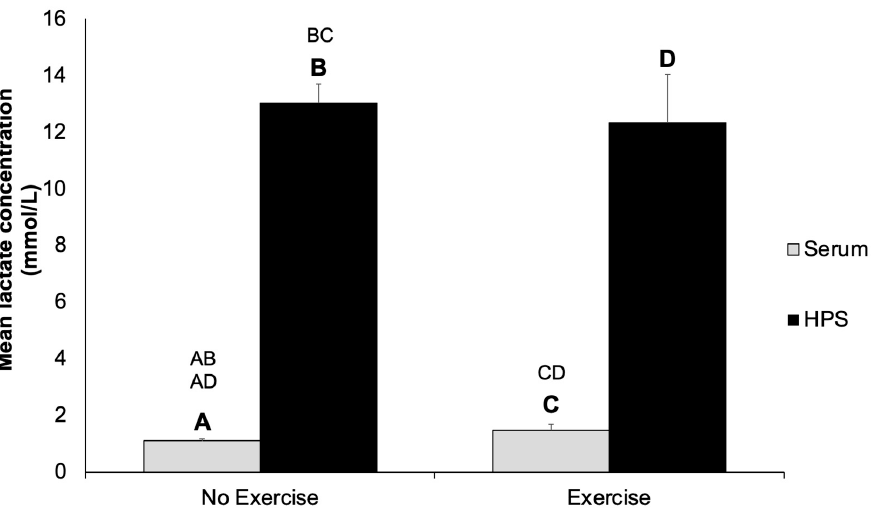
Figure 1. Quantitative analysis of lactate concentration in fresh serum and hypoxia preconditioned serum (HPS) in non-exercising and exercising subjects. Blood samples were obtained from subjects who exercised less than two hours per week (no-exercise group, n = 6) and from subjects who exercised more than two hours per week (exercise group, n = 6). Two-way ANOVA with Tukey’s multiple comparison test. Data points are means ± SD. Capital letter pairs over plots indicate statistical comparison of corresponding data points. For all pair comparisons, p <